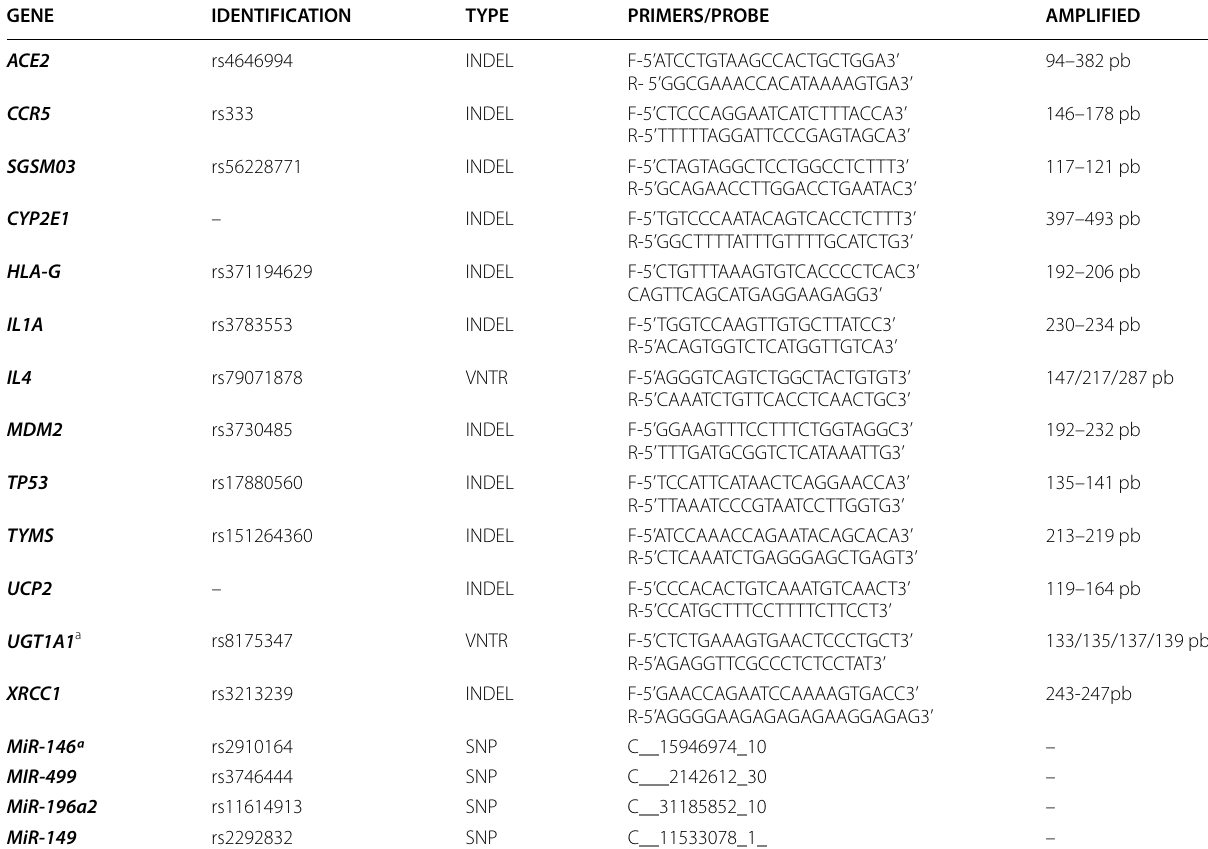
Table 2 Description of polymorphisms